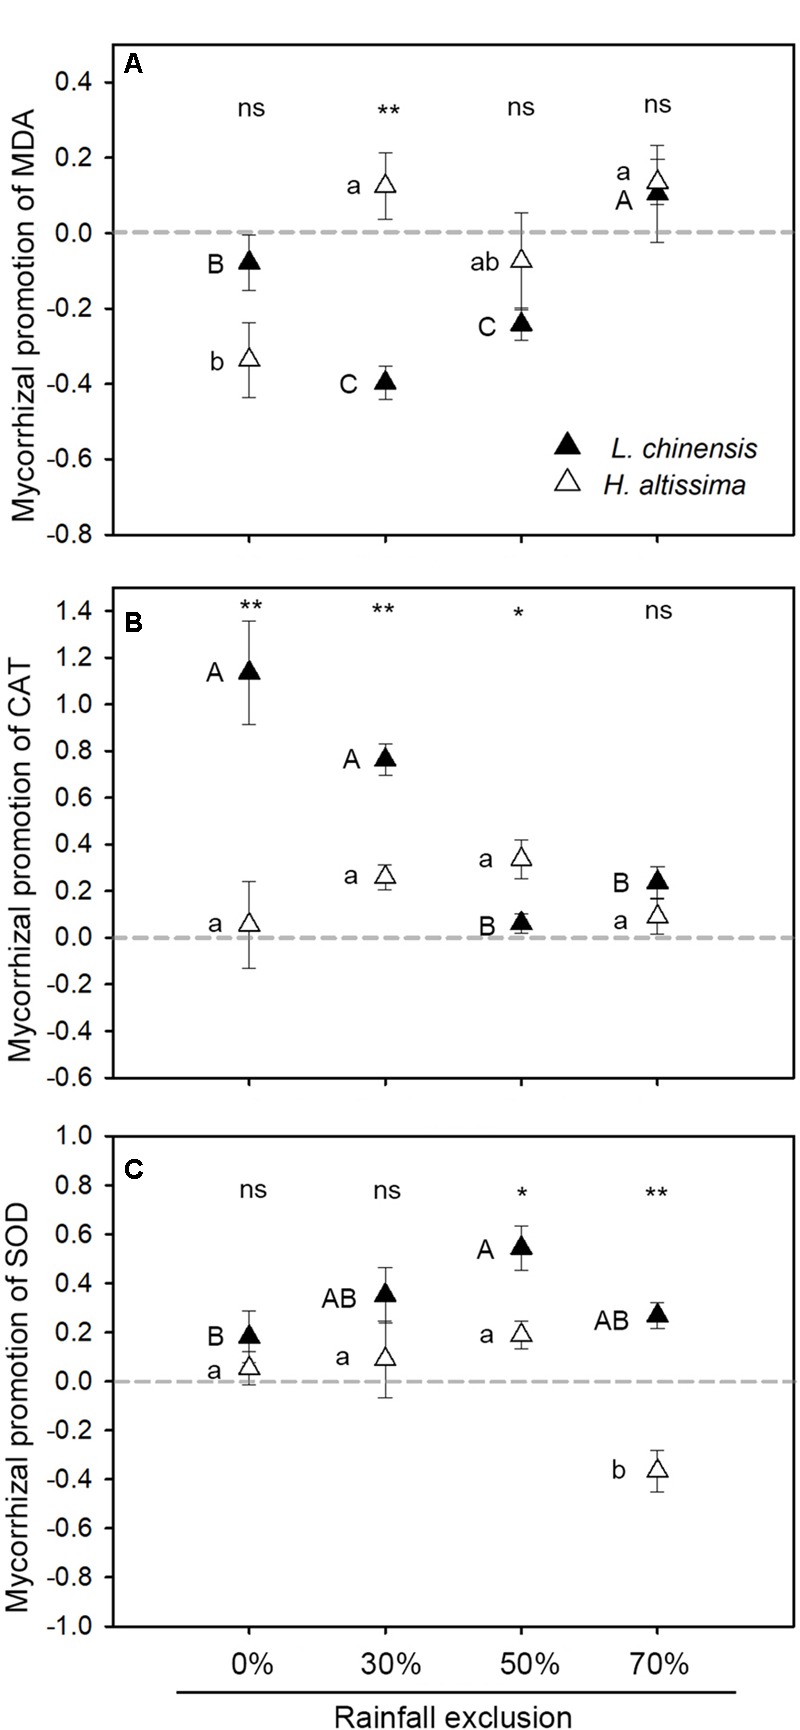
Mycorrhizal response of malondialdehyde (MDA, A) and antioxidant enzyme, including catalase (CAT, B), and superoxide dismutase (SOD, C), in L. chinensis and H. altissima. Mycorrhizal benefit existed when values of mycorrhizal response were greater than zero. ∗P < 0.05 and ∗∗P < 0.01 indicates significant differences and ns (P > 0.05) indicates no differences between L. chinensis and H. altissima. Data are reported as mean ± 1 SE (n = 4).